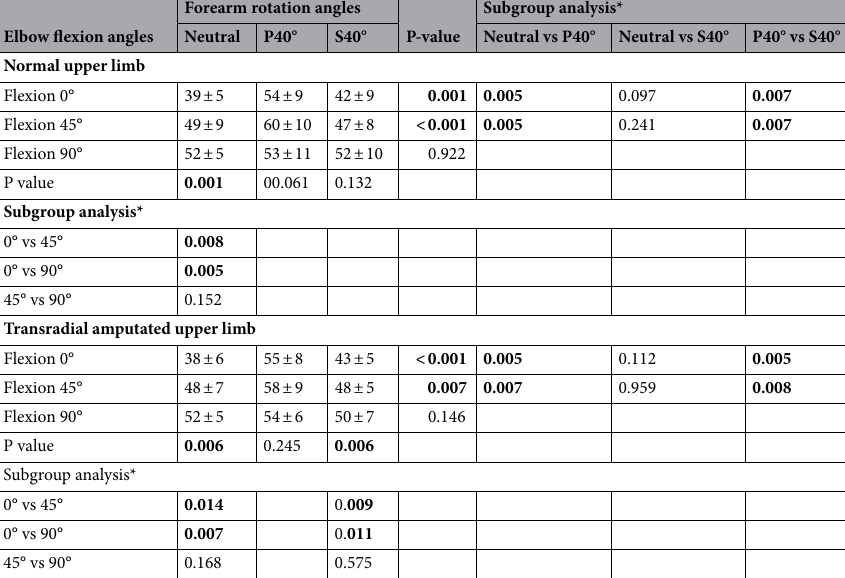
Table 1. Contact area of the radiocapitellar joint at various degrees of elbow flexion and forearm rotation angles in normal and transradial amputated upper limbs. P40°, 40° pronation; S40°, 40° supination. Boldface indicates significance. Values are presented as mean ± SD (mm 2 ). *The significance level was corrected from 0.05 to 0.017 (5%/3) by Bonferroni’s